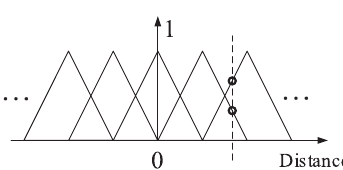
Figure 2. The membership functions for one